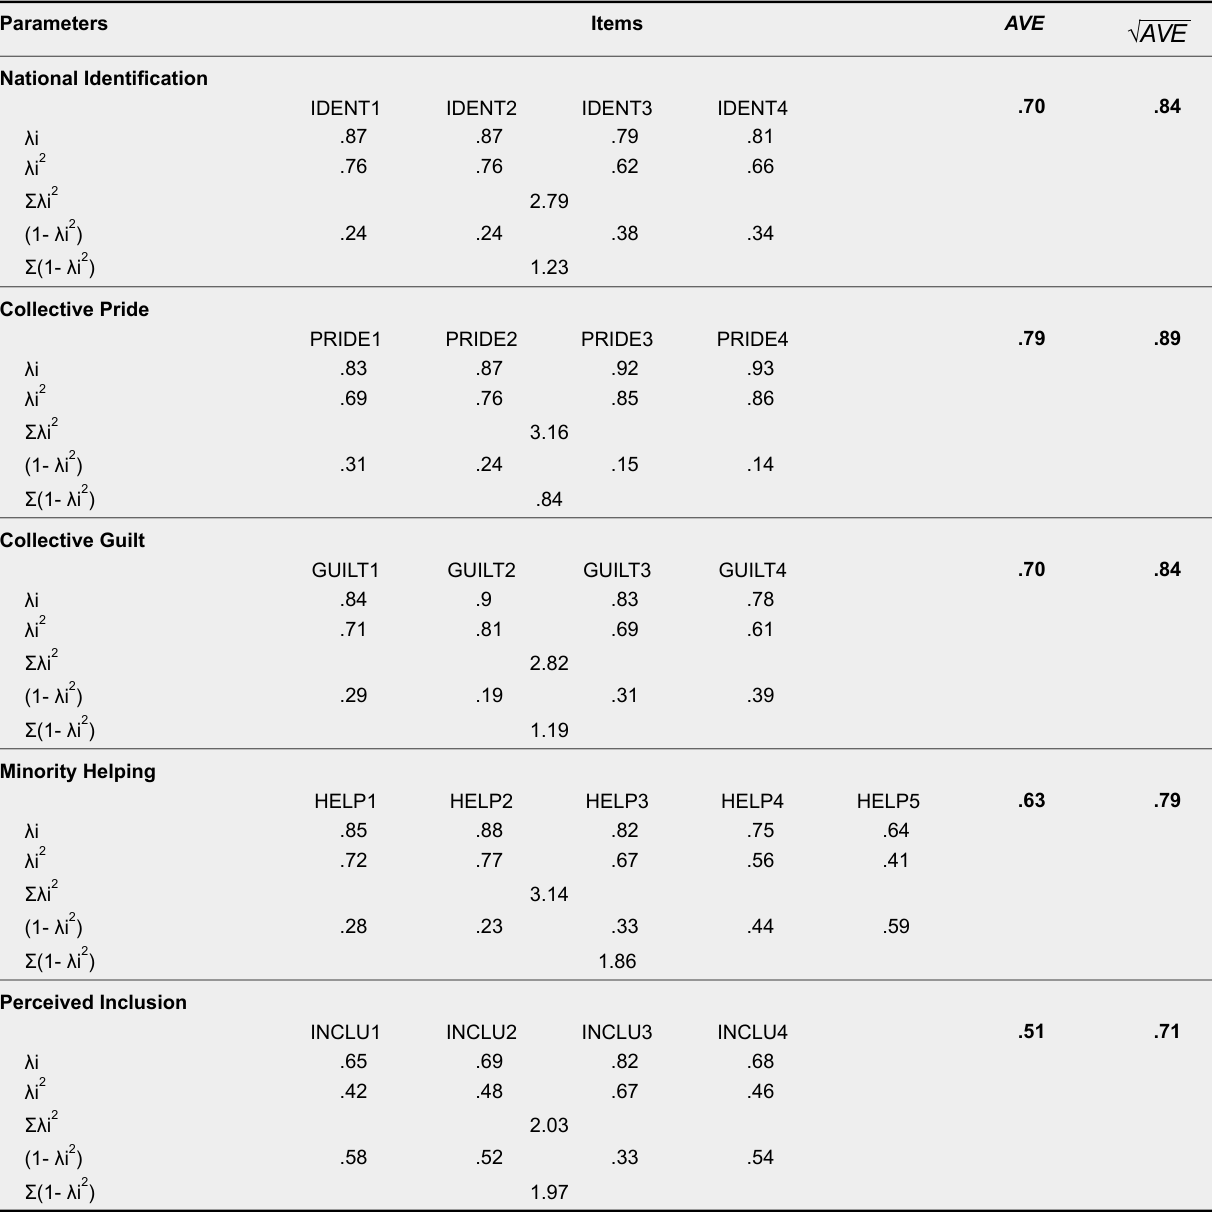
Average Variance Extracted (AVE) and Squared Root Average Variance Extracted of Each Variable in the Study